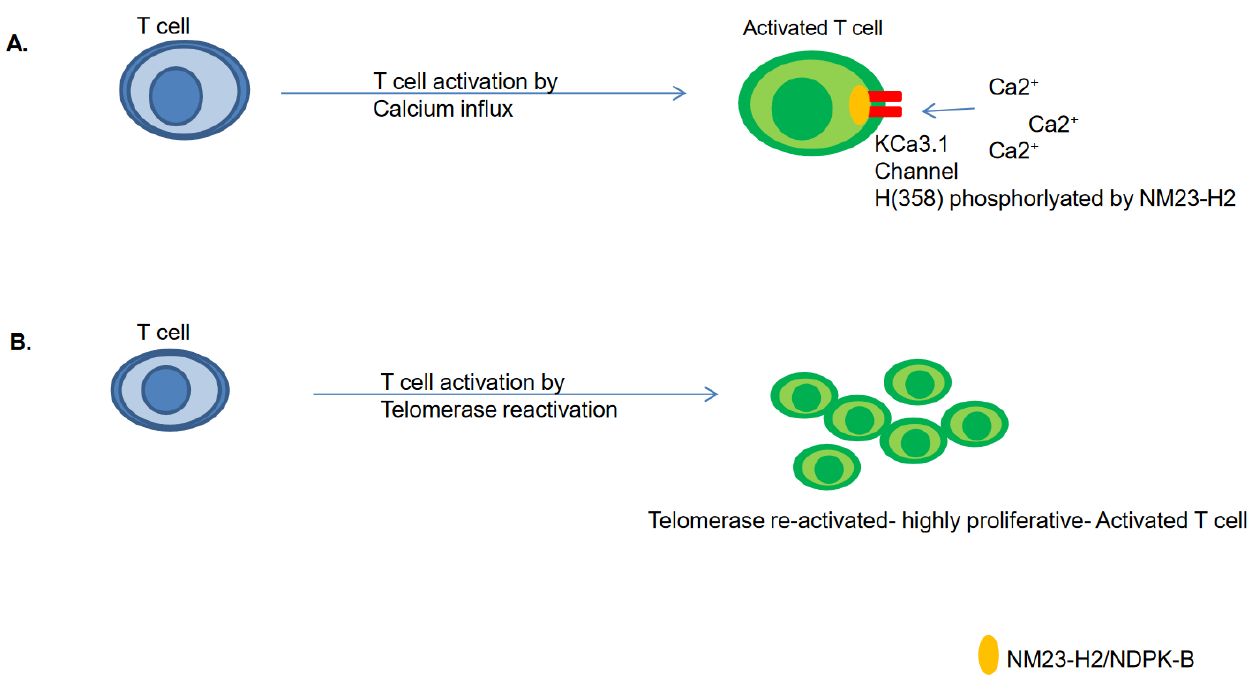
Figure 3. NM23-H2 could be mediating T cell activation by governing Ca 2+ influx along with telomerase re-activation. ( A ) NM23-H2/NDPK-B phosphorylates KCa3.1 channel at Histidine 358 position, mediating T-cell activation [66], ( B ) Telomerase re-activation by depletion of NM23-H2 might induce hyper-proliferation of activated T cells [69–72].